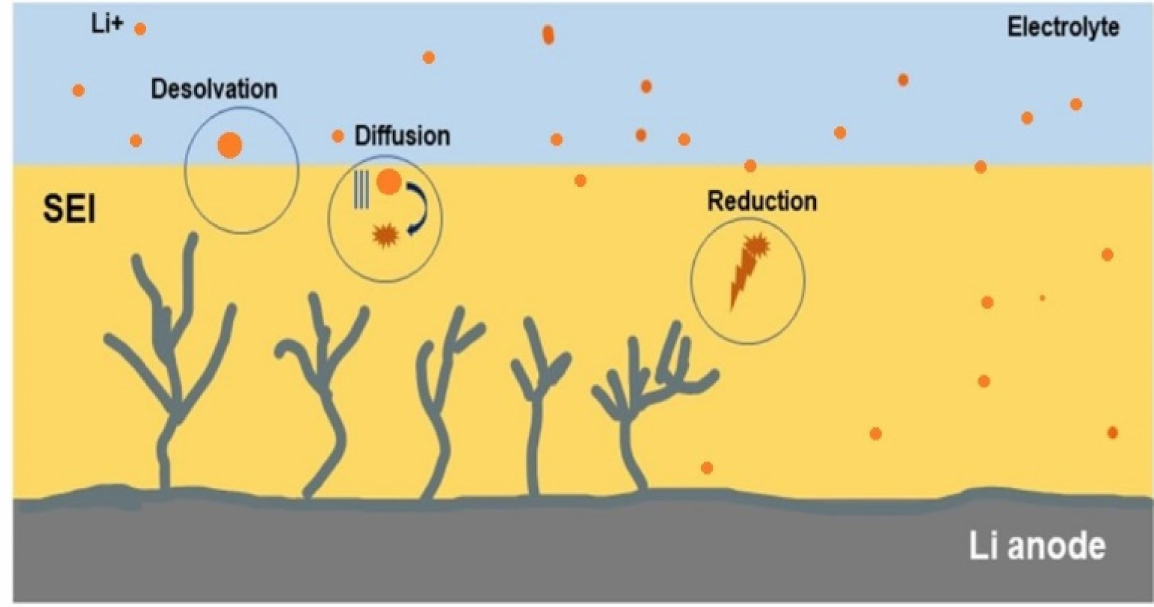
Figure 20. Schematic representation of dendrite growth